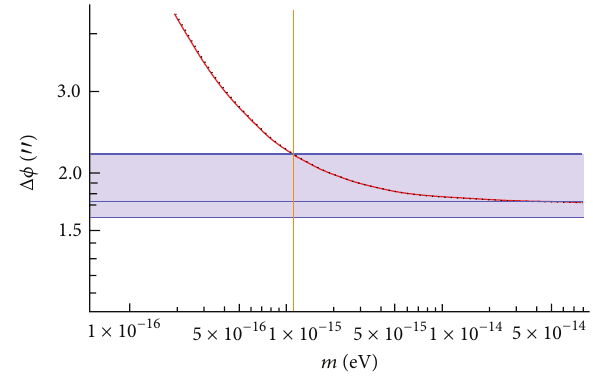
Figure 1: Numerical results for the angular deviation Δ𝜙 as a function of 𝑚 𝛾 . The horizontal lines represent a conservative range for the measured gravitational lensing by the sun [25]. Please note thatthisrangecanbelargelyimprovedbymeasurementsusingradio astronomy [24, 26]. The red line is the numerical value for both configurations of ± 𝜙 = ± 𝑡 . The black dotted line is the analytic estimate (9). The vertical line is the deduced minimal value for 𝑚 𝛾 given in